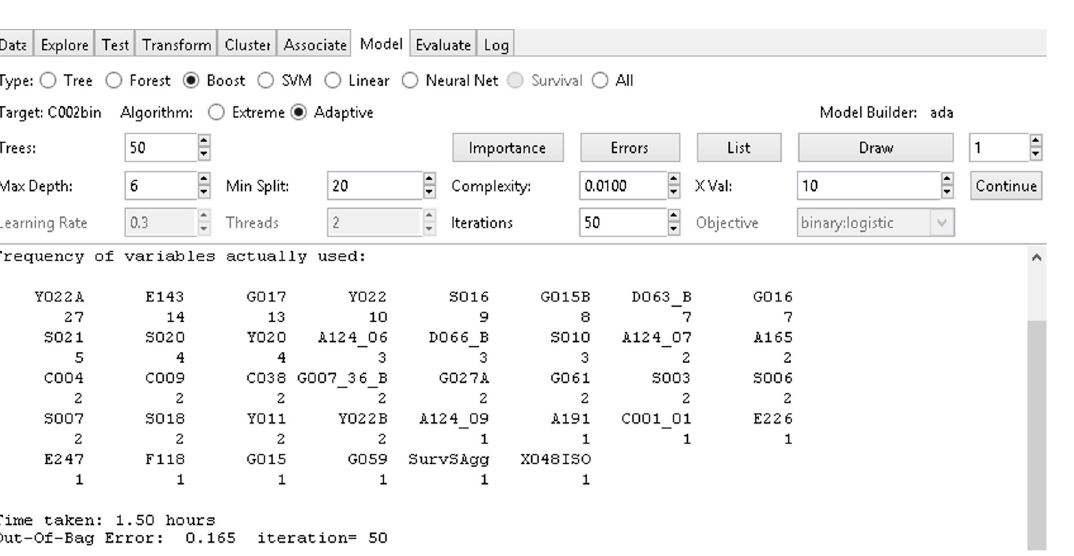
Figure 1. The results of the first selection round using adaptive (Ada) boosting in Rattle.